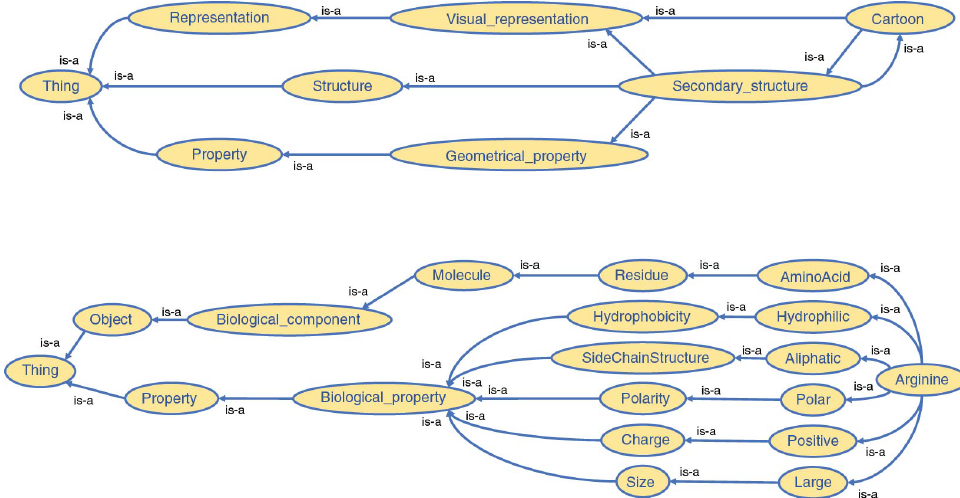
Figure 3: A part of our structural biology ontology used in our